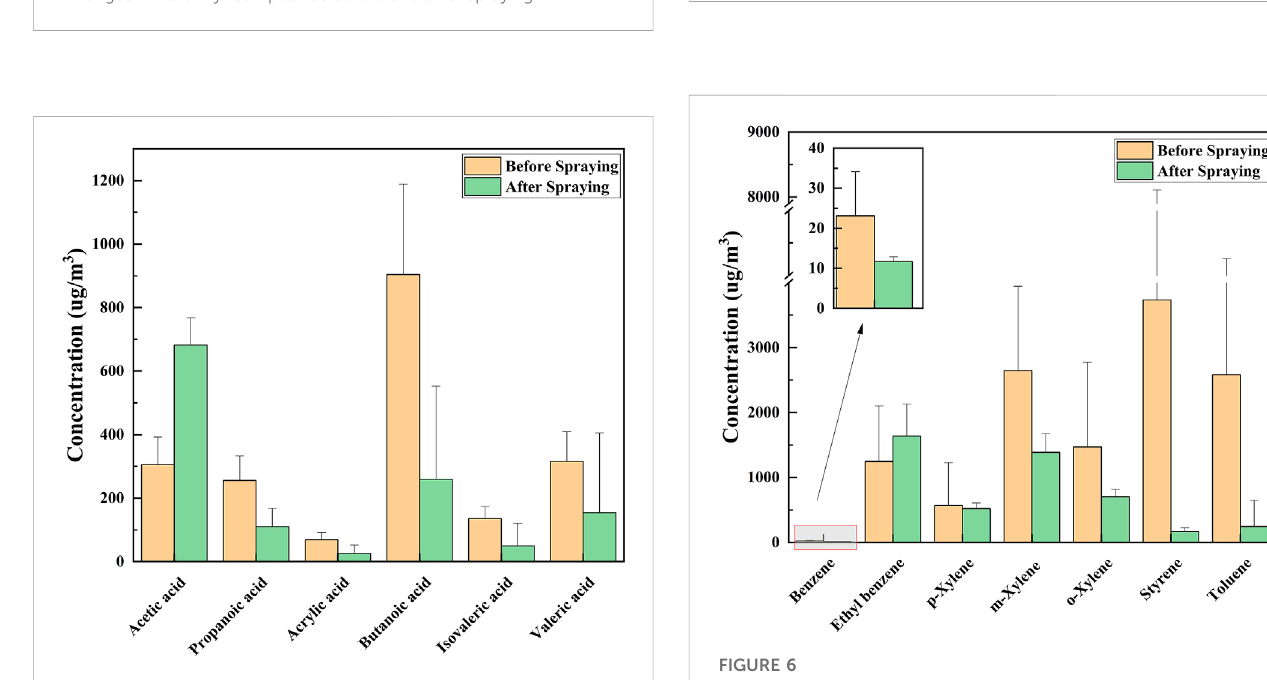
FIGURE 4 Changes in VFA compounds before and after spraying.